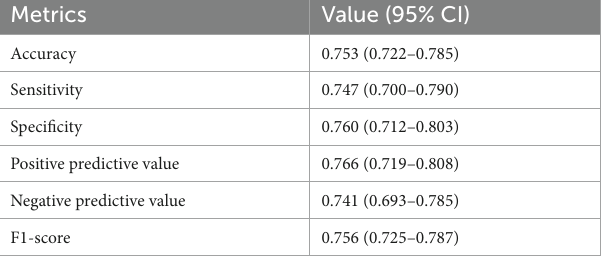
TABLE 6 Performance criteria for the DGA predict model.